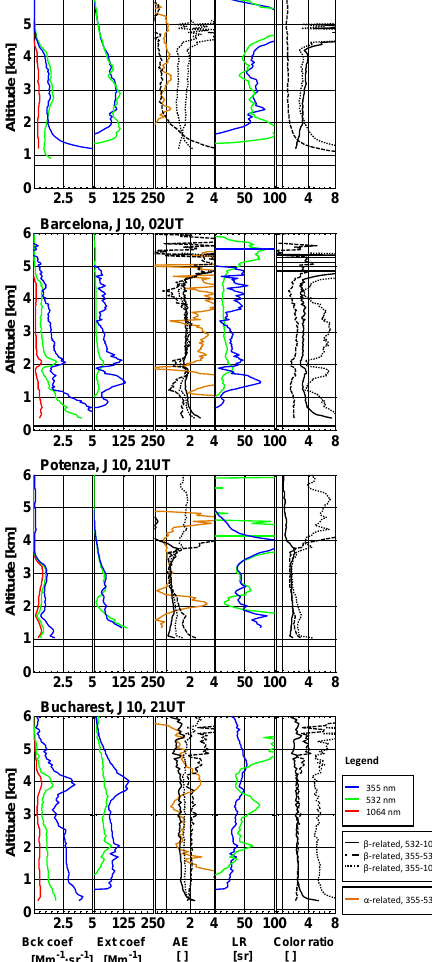
Figure 10. All optical products (SCC-2 direct and derived prod- ucts) at a selected time. The legend is the same for all the plots and is reported in the bottom right corner. The horizontal black lines represent the station’s altitude